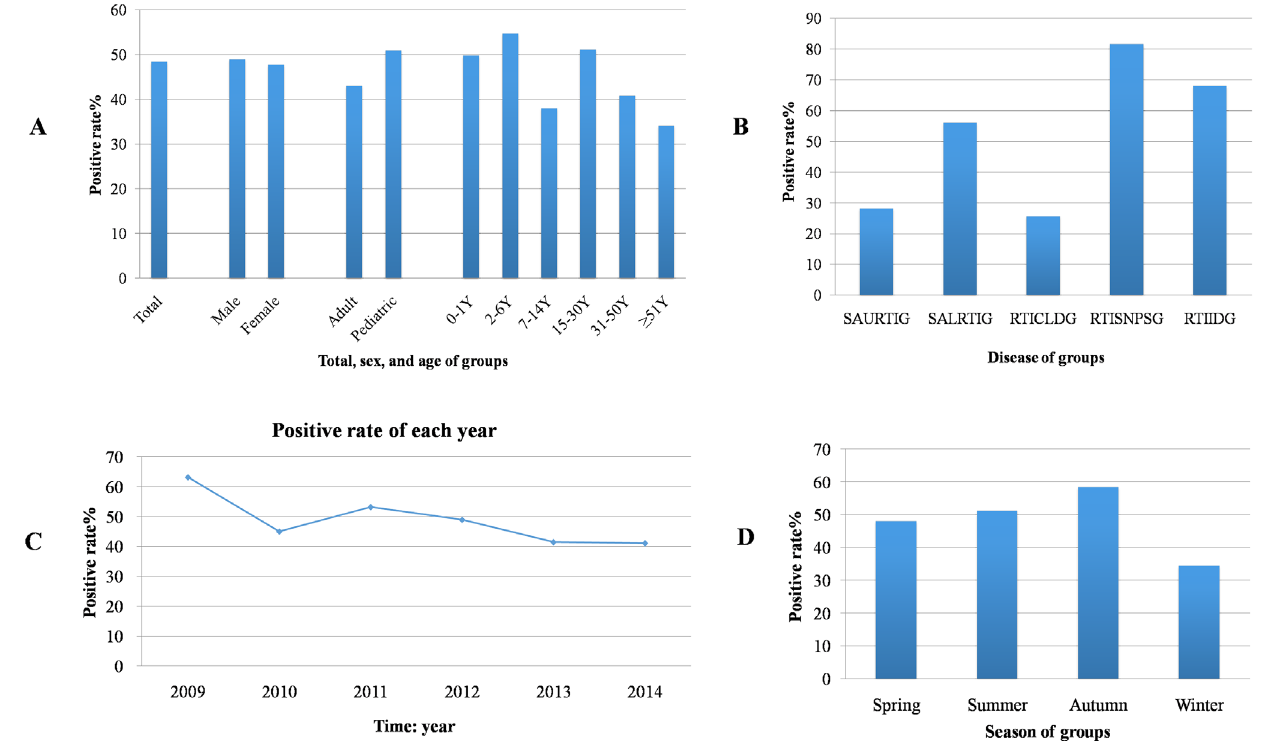
Fig 1. The overall distribution of the pathogens from July 2009 to June 2014. A, the positive detection rates (PDRs) according to patient total, sex, age and its subgroups; B, the PDRs of 5 different disease subgroups. (1) SAURTIG: The single acute upper RTI group. (2) SALRTIG: The single acute lower RTI group. (3) RTICLDG: The RTI with chronic lung disease group. (4) RTISNPSG: The RTI with severe non-pulmonary symptoms group. (5) RTIIDG: The RTI with immunocompromised diseases group; C, yearly PDRs; D, seasonal